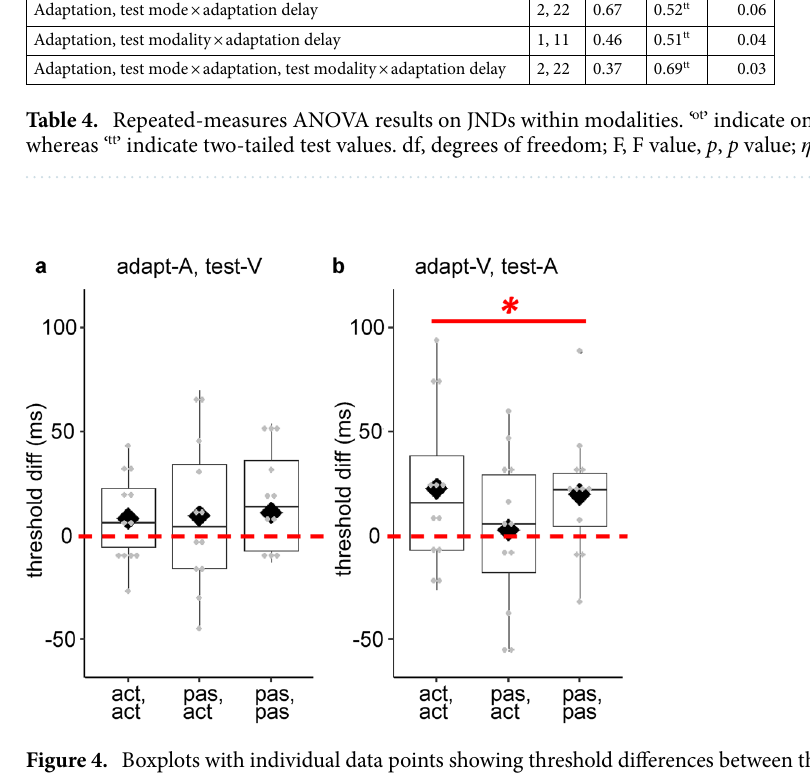
Figure 4. Boxplots with individual data points showing threshold differences between the 150 ms and 0 ms delay conditions as a function of adaptation, test mode in ( a ) the adapt-A, test-V, and ( b ) the adapt-V, test-A condition. Bold asterisk shows significant main effect of adaptation delay . The dashed line depicts 0 difference. Diamonds and solid lines show the mean and the median of the points,